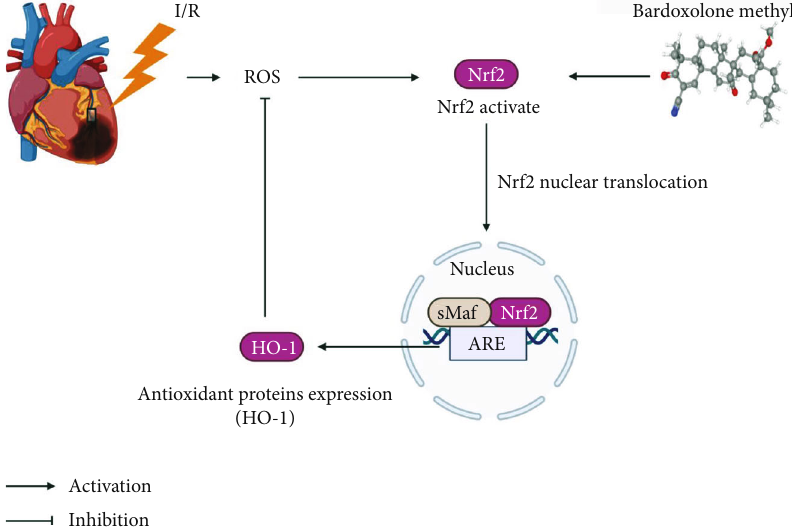
Figure 6: A graphical summary for the cardioprotective e ff ect of bardoxolone methyl (BARD) against myocardial I/R